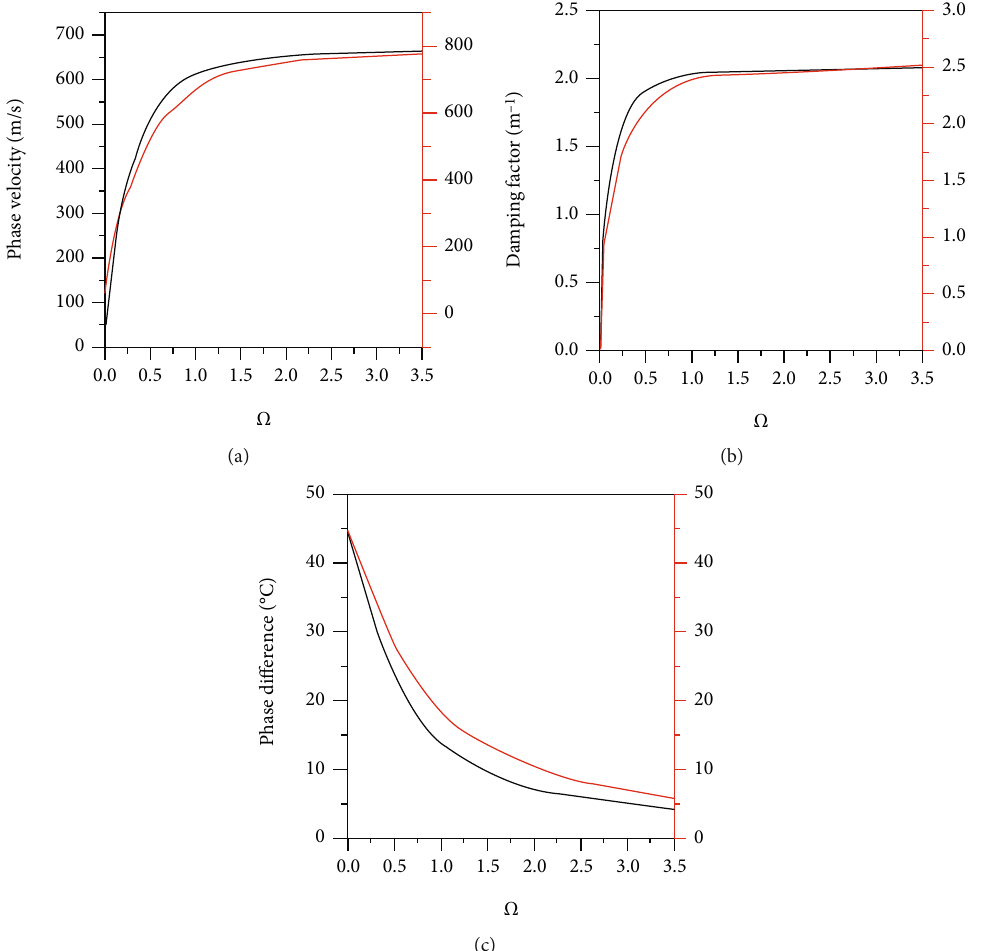
Figure 3: Phase velocity (a), damping factor (b), and phase di ff erence (c) of the second wave versus normalized frequency ( Ω = ω / ω red line presents the Darcy-Brinkman law and the black line Darcy ’ s